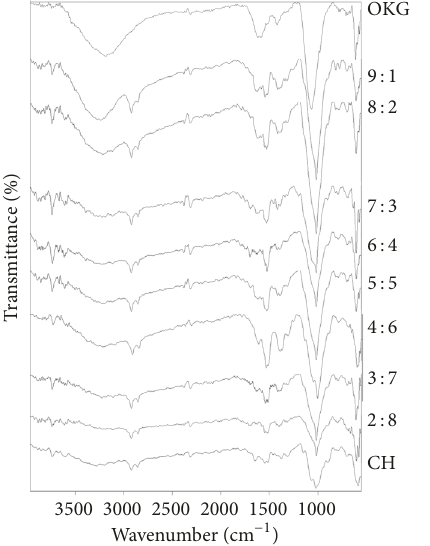
Figure 3: The FTIR spectra of OKG, PECs of ratios 2 :8, 3 : 7, 4 :6,